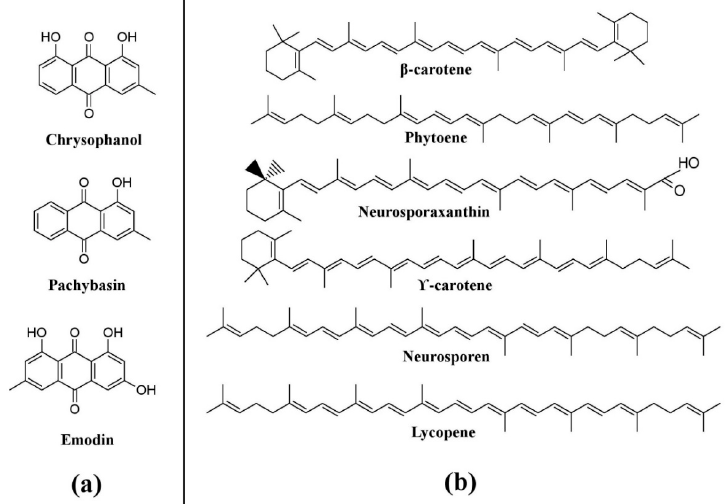
Figure 7. Pigments from other fungi. ( a ) Pigments from Trichoderma species, based on [25]. ( b ) Pigments from Neurospora species, re-drawn from [25,90].